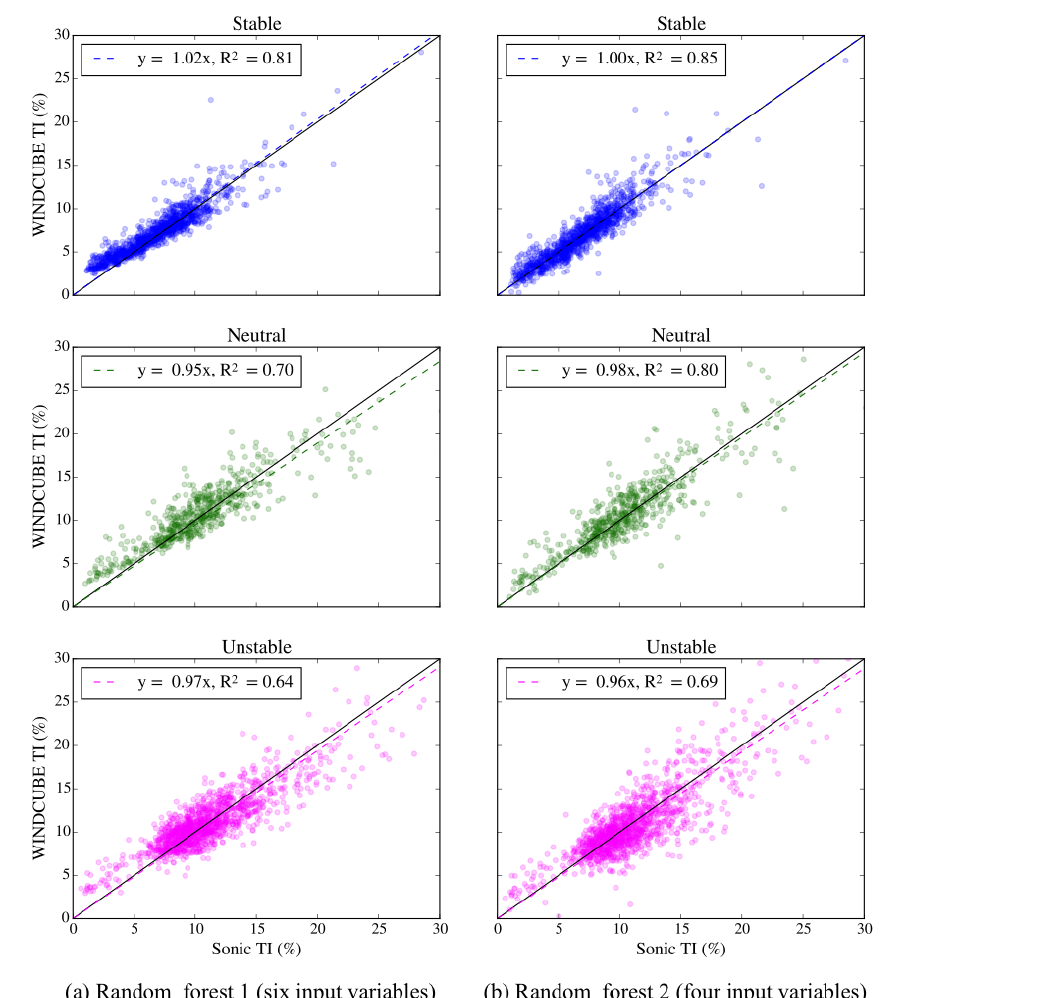
Figure 7. Scatterplots of met tower vs. WC TI for data from 60m measurement height at the ARM site (a) after the application of the first random forest described in the text and (b) after the application of the second random forest. The 1:1 line and regression lines are shown for